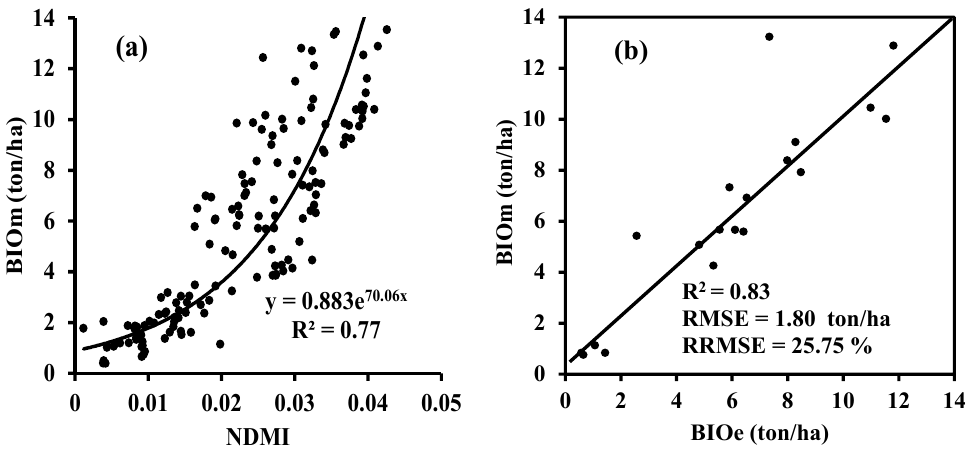
Figure 2. Regression model between biomass and normalized difference matter index (NDMI) ( a ); and model validation ( b ).